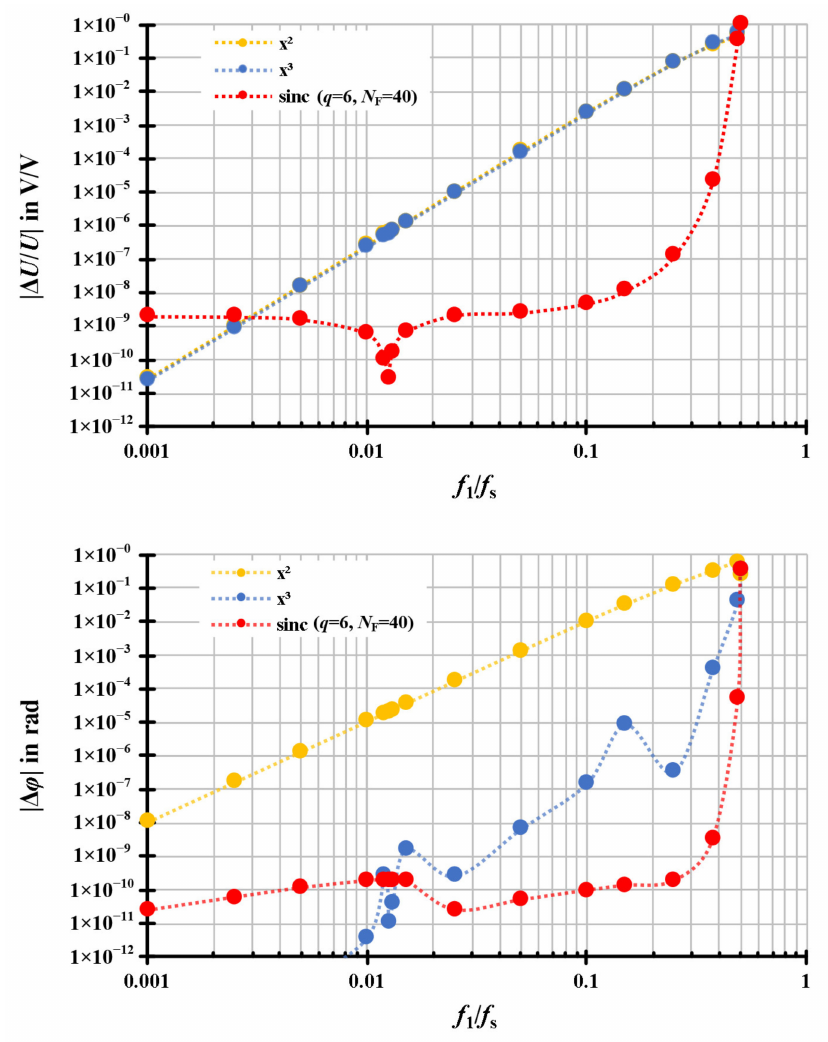
Figure 7. Frequency responses of the quadratic, the cubic and the modified sinc interpolations. The signals are simulated with parameters of f S = 4000 Hz, T W = 1 s, U 1 = 1 V, and ϕ 1 = 0 ◦ without noise and the harmonic series. The orange dots represent the results of the interpolation based on the quadratic function. The blue dots represent the results of the interpolation based on the cubic function. The red dots represent the results of the modified sinc